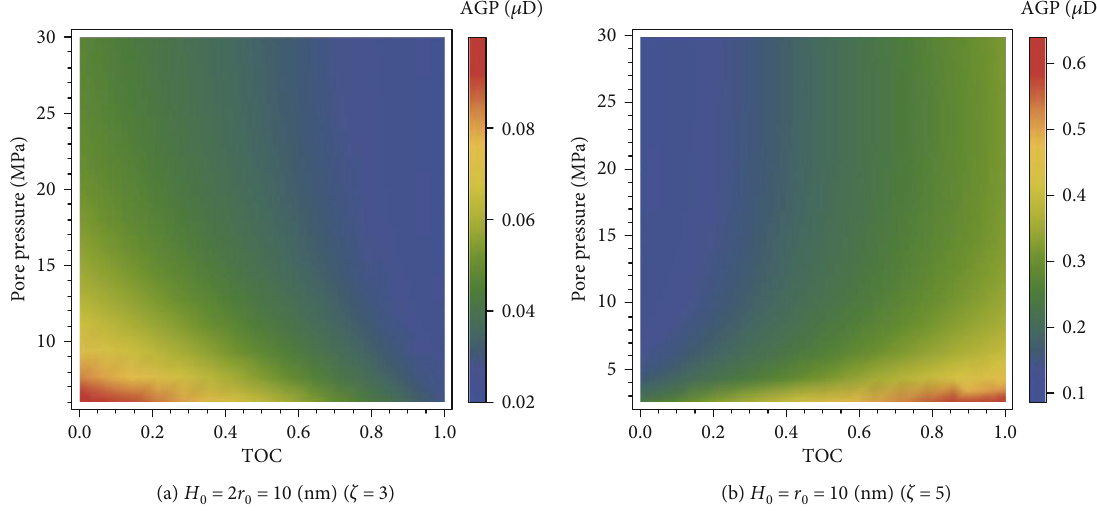
Figure 12: The impact of TOC contents on the AGP of